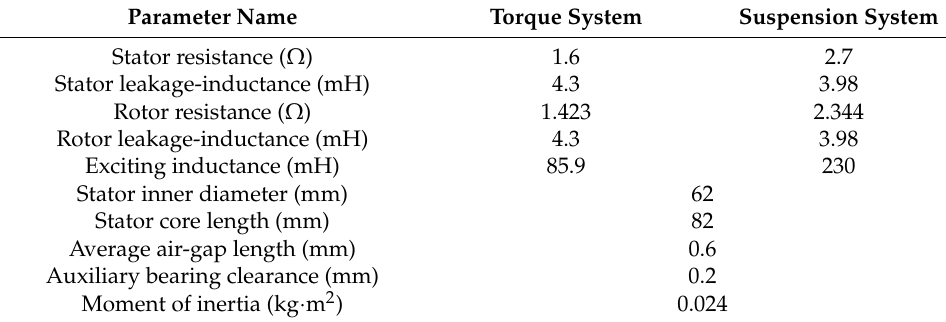
Table 1. BL-IM’s